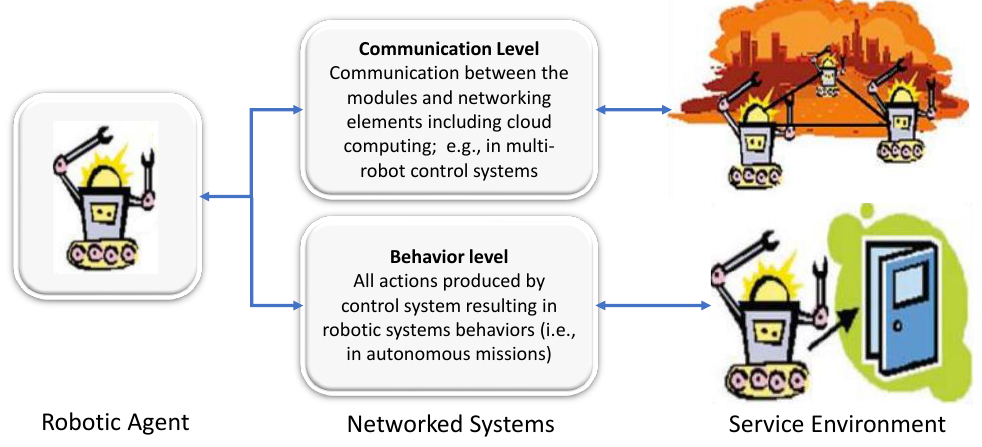
Figure 1. Networked robotic platforms—two levels of communication. Communication level concerns the interaction within the system modules and networking elements. Behavior level delineates local decision making produced by system modules. The idea is adopted from